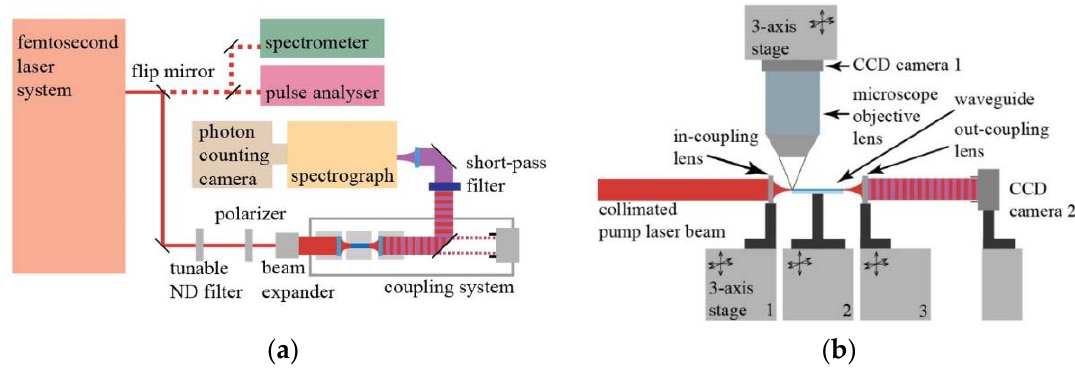
Figure 2. ( a ) Top view of the experimental setup with the end-fire coupling system. Femtosecond pulses of vertical polarization are adequately attenuated with a neutral density (ND) filter and coupled into GaN waveguides with their polar axis vertical. The out-coupled signal is vertically polarized and is filtered with a shortpass filter and the SHG signal is analyzed with the spectrograph connected to the photon counting camera. ( b ) Side-view of the end-fire coupling system. Coupling lenses and a sample holder are mounted on xyz translation stages, which enable precise positioning of the focal point of the laser beam onto the front facet of the waveguide.